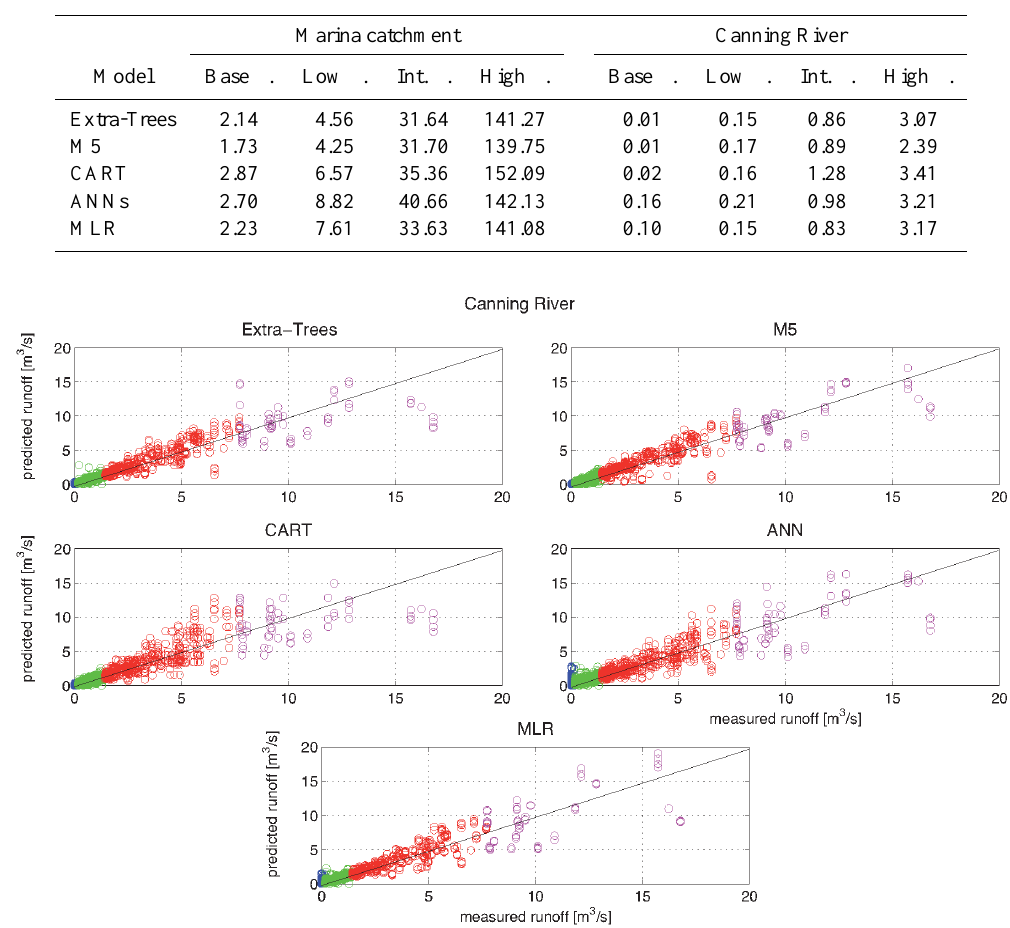
Table 9. Testing results, in terms of RMSE [m 3 s − 1 ], of Extra-Trees and benchmarking models for Marina catchment and Canning River datasets on four different flow regimes.